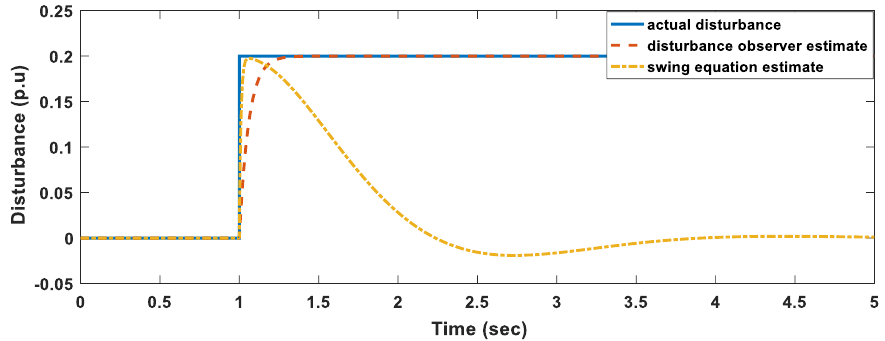
Figure 15. Scenario 4 disturbance observer vs swing equation